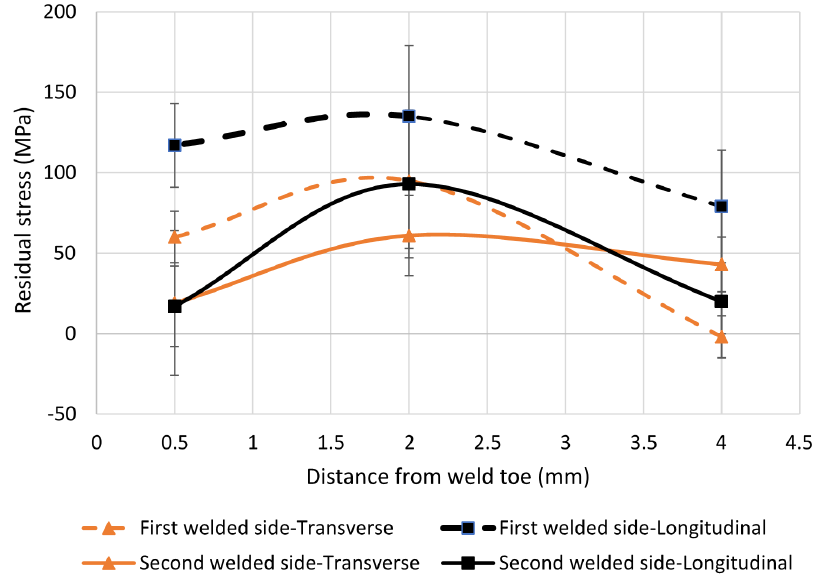
Figure 9. Transverse and longitudinal surface residual stresses close to the weld toe.